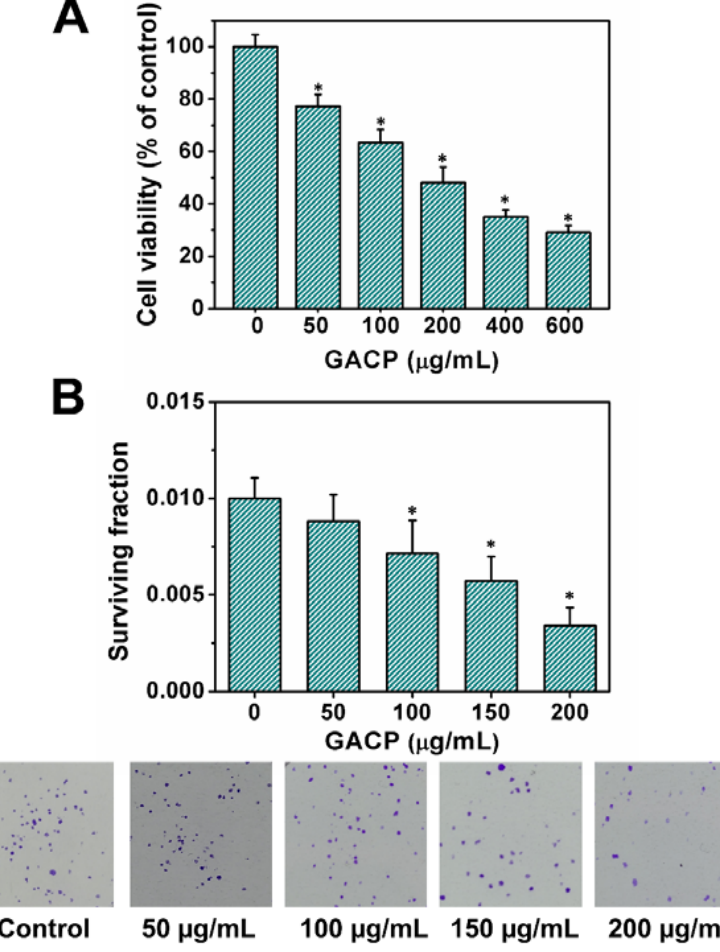
Figure 5. The effect of GACP on cell viability and cell proliferation: Cytotoxic effect on MG-G3 by MTT assay ( A ) and clonogenic assay ( B ) after 24 h of incubation. The values are presented as the mean ± SD ( n = 3). *: statistically significant differences between control and treatment ( p < 0.001).